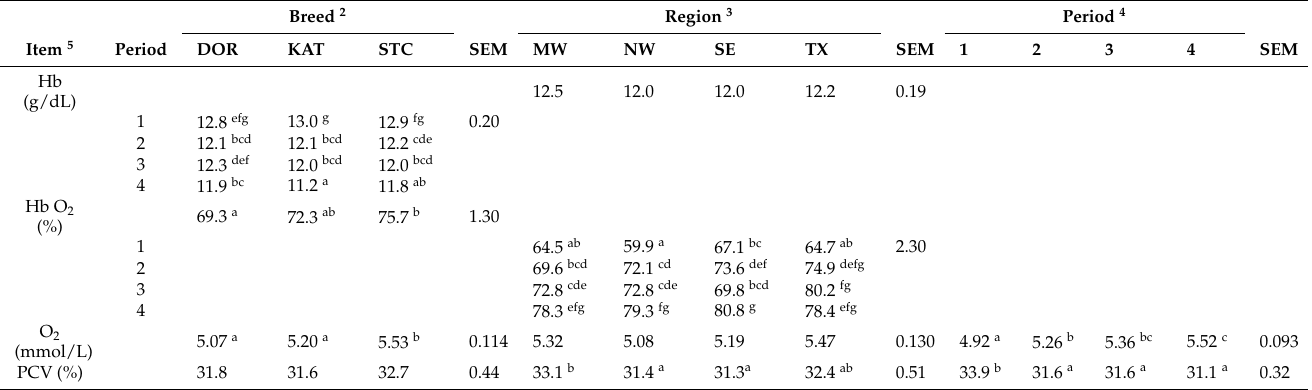
Table 3. Effects of breed, region, and period with different heat load indexes on hemoglobin concen- tration and oxygen saturation, blood oxygen concentration, and packed cell volume (PCV) in hair sheep based on samples collected at the end of the week 2 of each of the four 2 weeks periods 1 . Breed